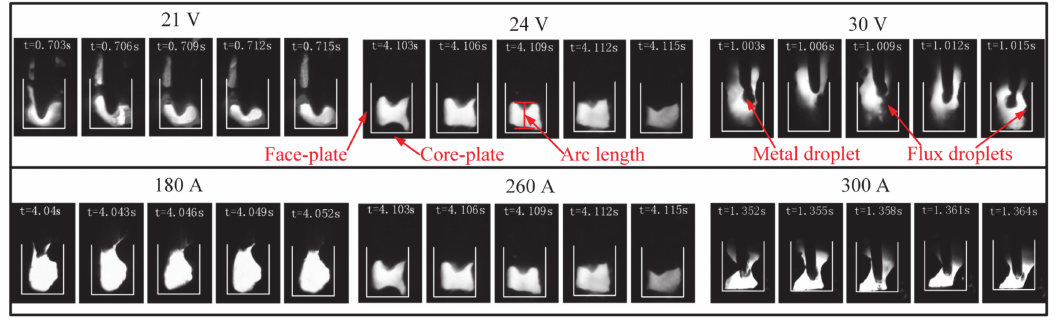
Figure 6. The arc behavior under di ff erent arc voltages and welding currents.